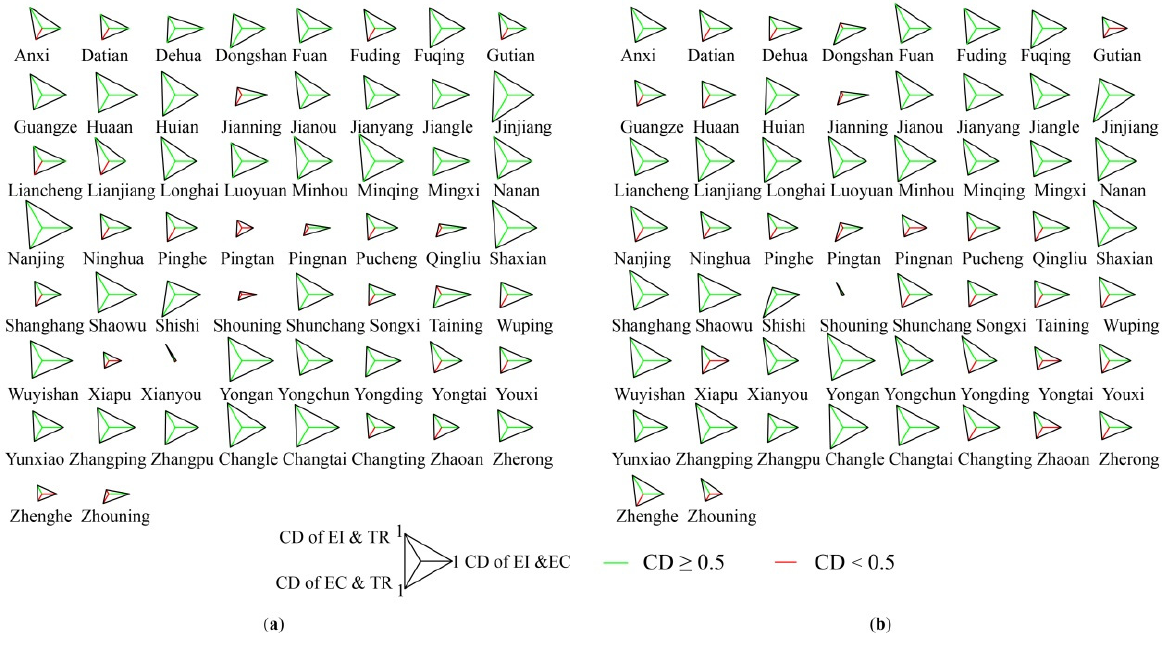
Figure 5. Coordination degree between EI, EC and TR at the county level in Fujian province in 2000 and 2018. ( a ) 2000; ( b )